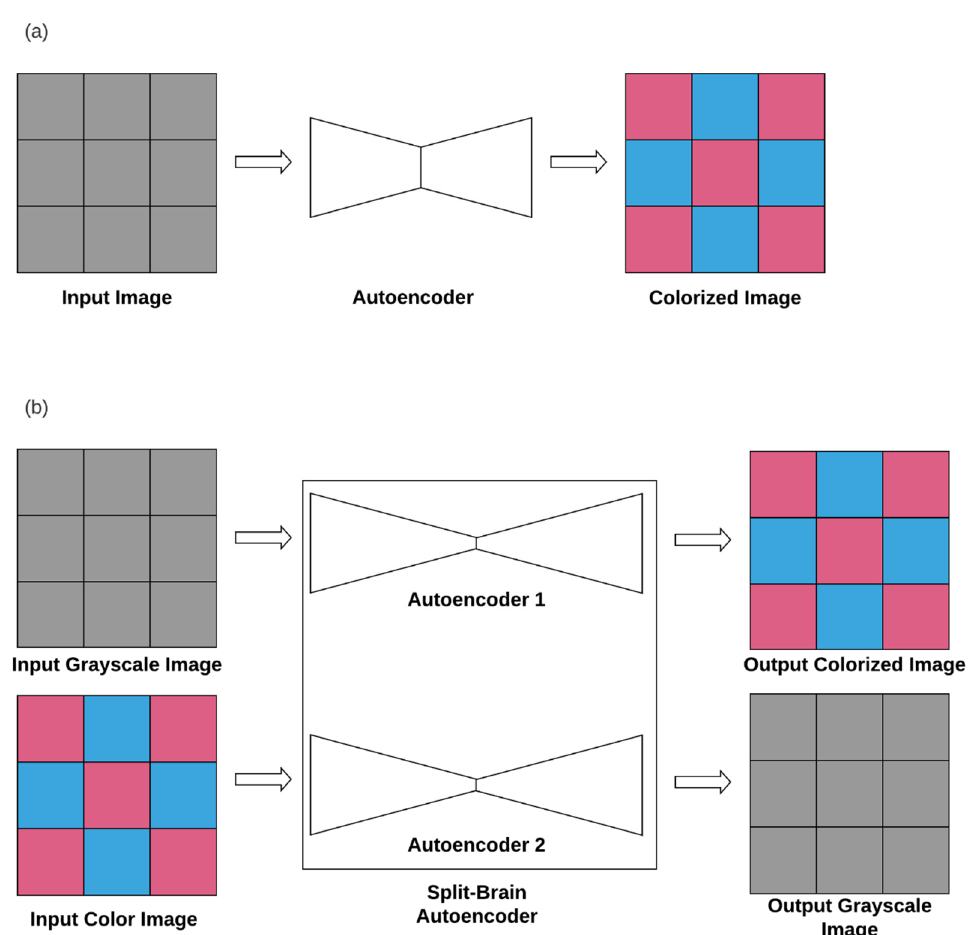
Figure 9. ( a ) An illustration of the algorithm used in [54]. A grayscale image is passed to an autoencoder, which is tasked with predicting the colorized version of the image. ( b ) An illustration of the algorithm used in [55]. A grayscale and colorized version of the same image are passed to two separate autoencoders, which are tasked with predicting the colorized and grayscale versions of their input images.